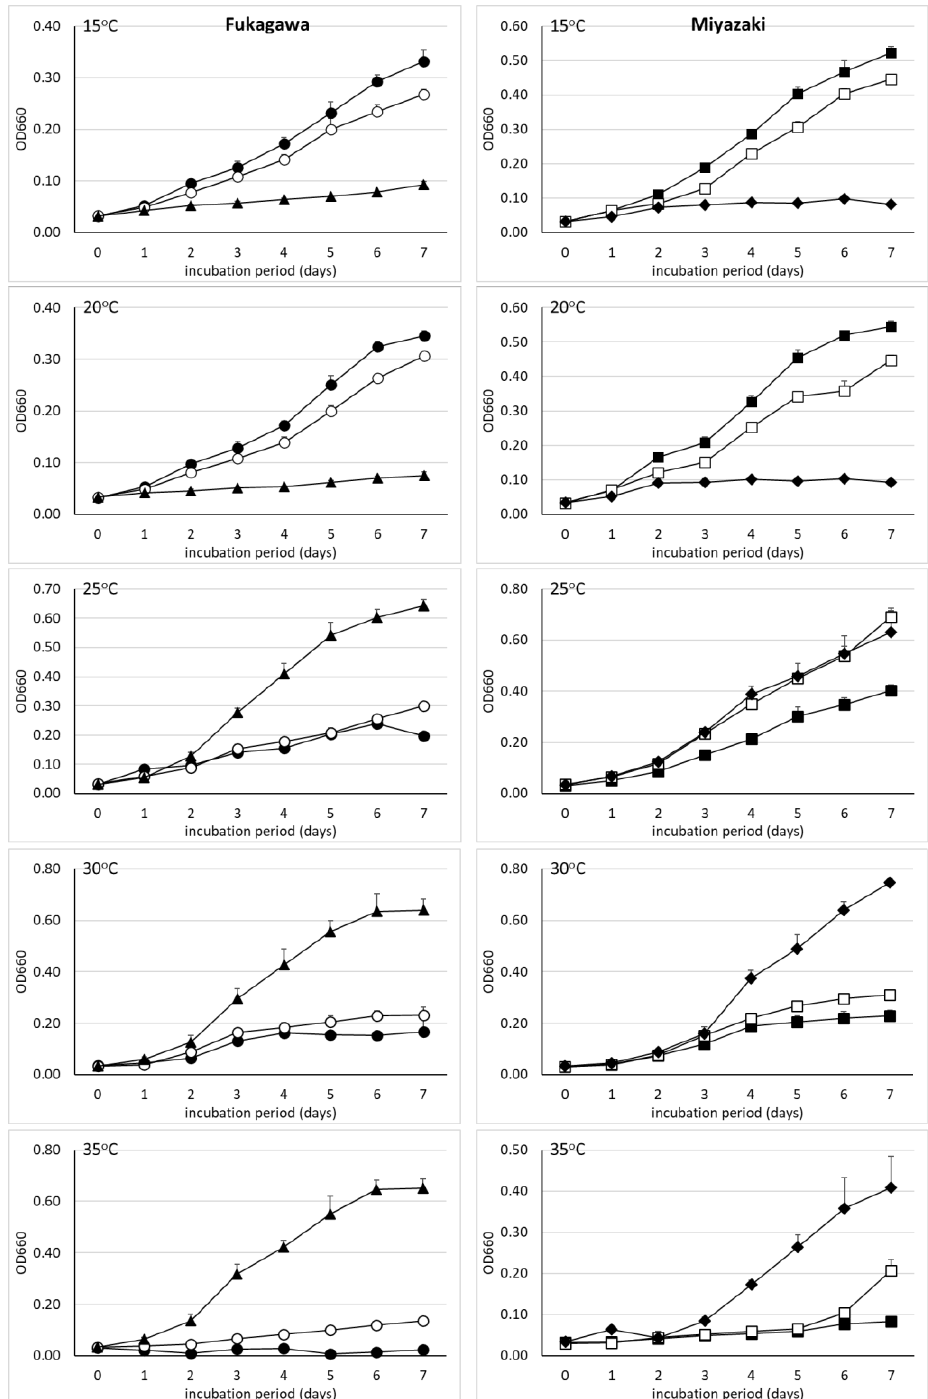
Figure 1. Effects of temperature on growth of Bradyrhizobium spp. strains in liquid culture. Fukagawa strains: B. japonicum Hh 16-9 (Bj11- 1) (●), B. japonicum Hh 16-25 (Bj11-2) ( ○ ), and B. elkanii Hk 16-7 (BeL7) ( ▲ ); Miyazaki strains: B. japonicum Kh 16-43 (Bj10J-2) ( ■ ), B. japonicum Kh 16-64 (Bj10J-4) (□), and B. elkanii Kh 16-7 (BeL7) ( ◆ ). The bars represent the standard deviation ( n = 3).